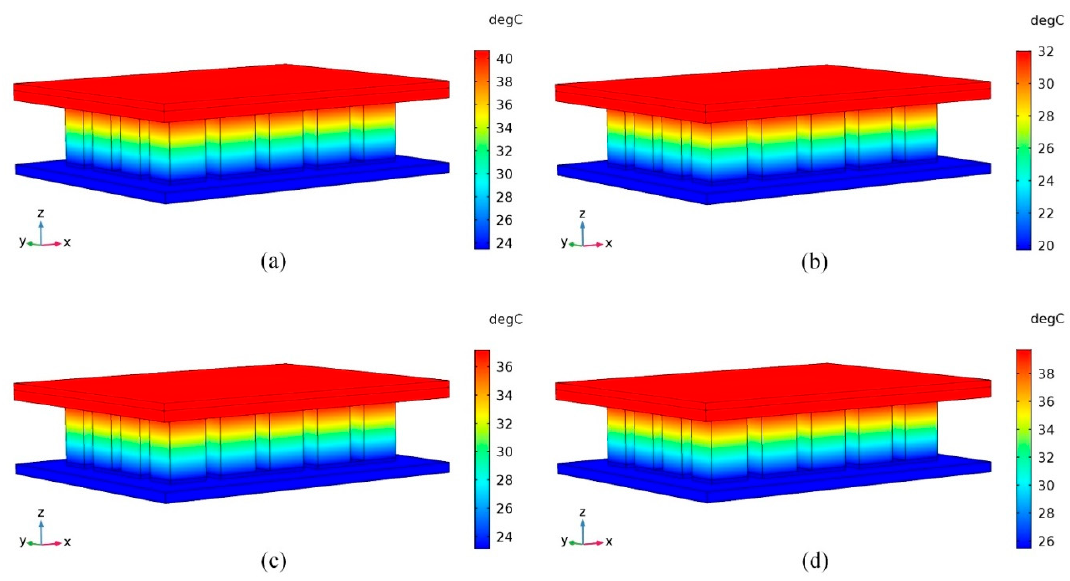
Figure 15. STEG temperature distribution with heat sink ( a ) fall equinox—March, ( b ) winter solstice—June, ( c ) spring equinox—September, ( d ) summer solstice—December.